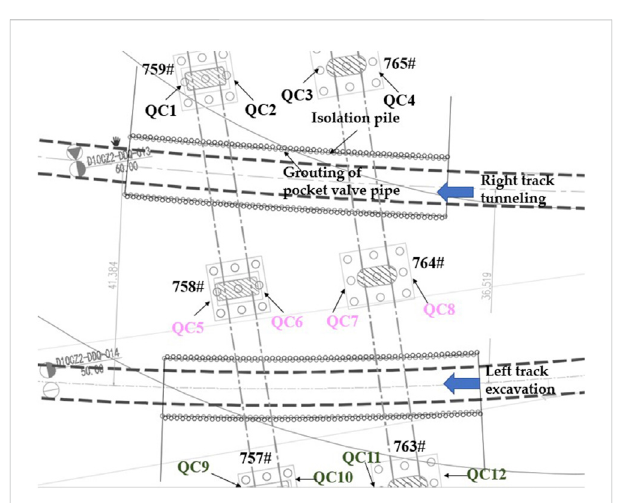
FIGURE 3 Layout plan of isolation piles in the under-crossing